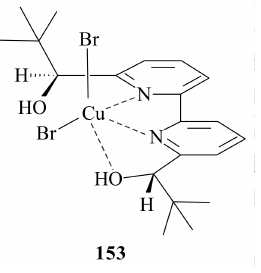
Figure 31. Tridentate coordination of an α , α ’-bipyridinyl diol with